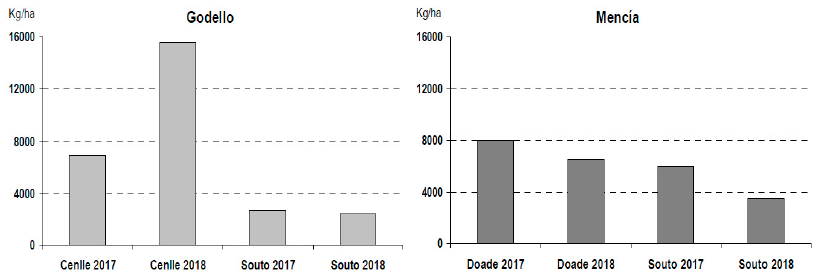
Figure 6. Production of grape (kg/ha) of Godello and Mencía varieties in each vineyard and studied year.